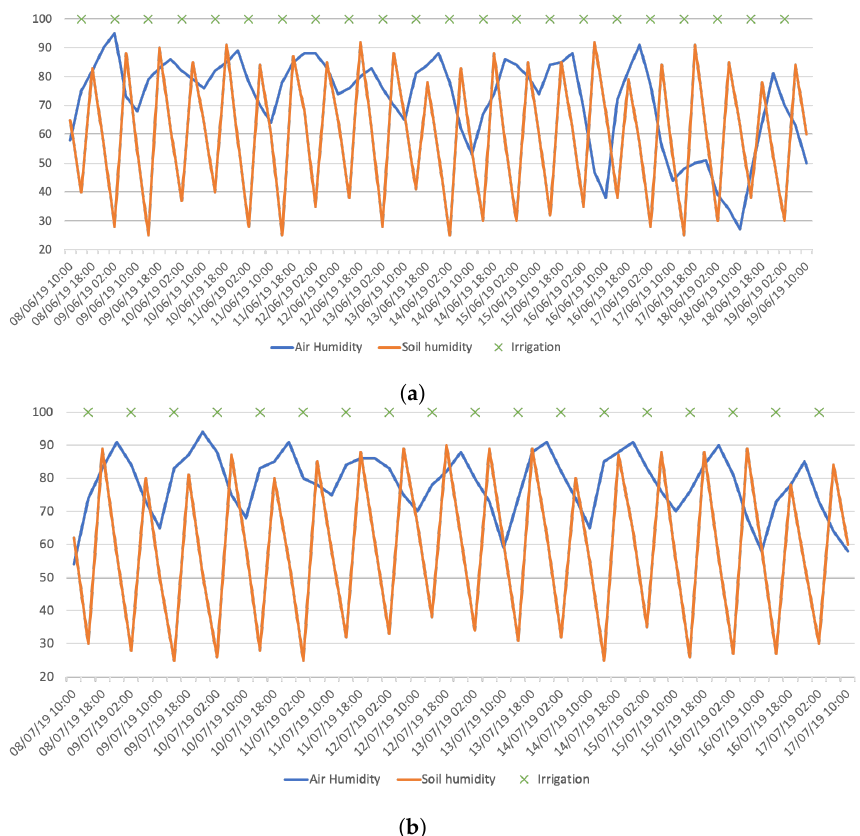
Figure 6. Data collected: ( a ) 2 week June data; ( b ) 2 week July